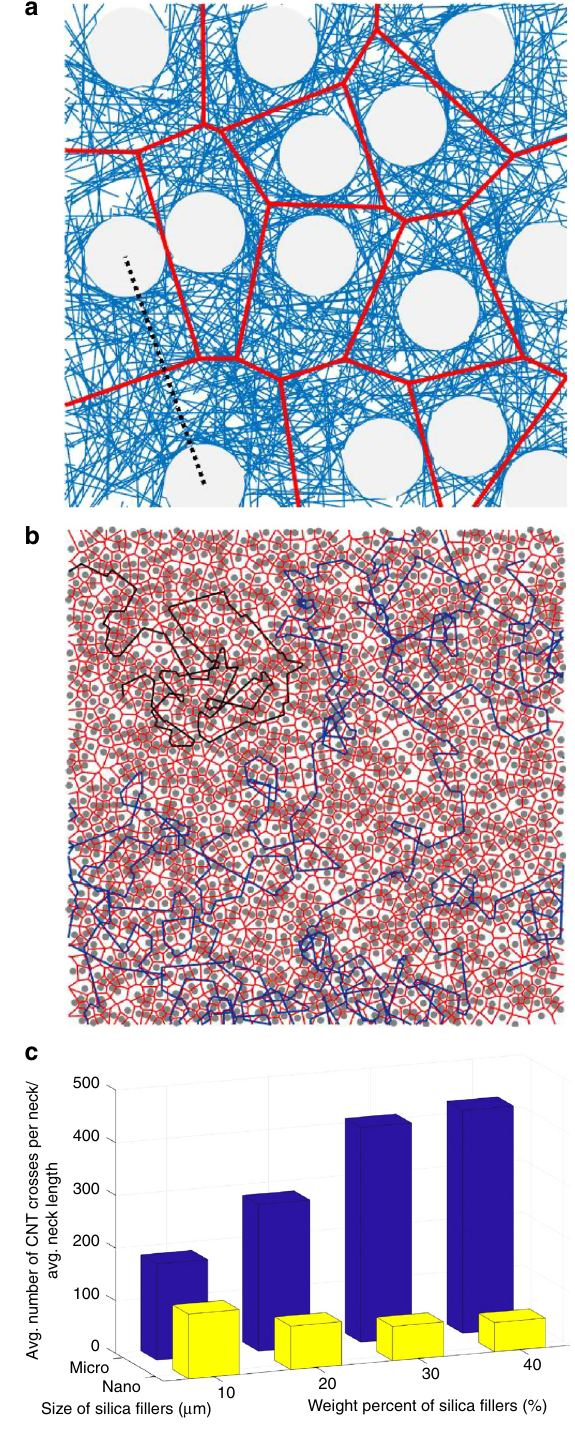
Fig. 7 Voronoi tessellations (represented in red solid lines). Voronoi geometries are constructed based on center points of silica fi llers (gray circles) a with a diameter of 4 μ m and b with a diameter of 20 nm over the 2D model illustrated in Supplementary Fig. 10(b) and (d), respectively. A straight line connecting the center points of the two nearest silica fi llers (represented in black dashed line in a ) in the normal direction of a red conducting path (the side of a Voronoi tessellation) is associated with a neck in the 2D model. c Average number of CNT crosses per neck/average neck length for micro- and nano-silica composites with respect to